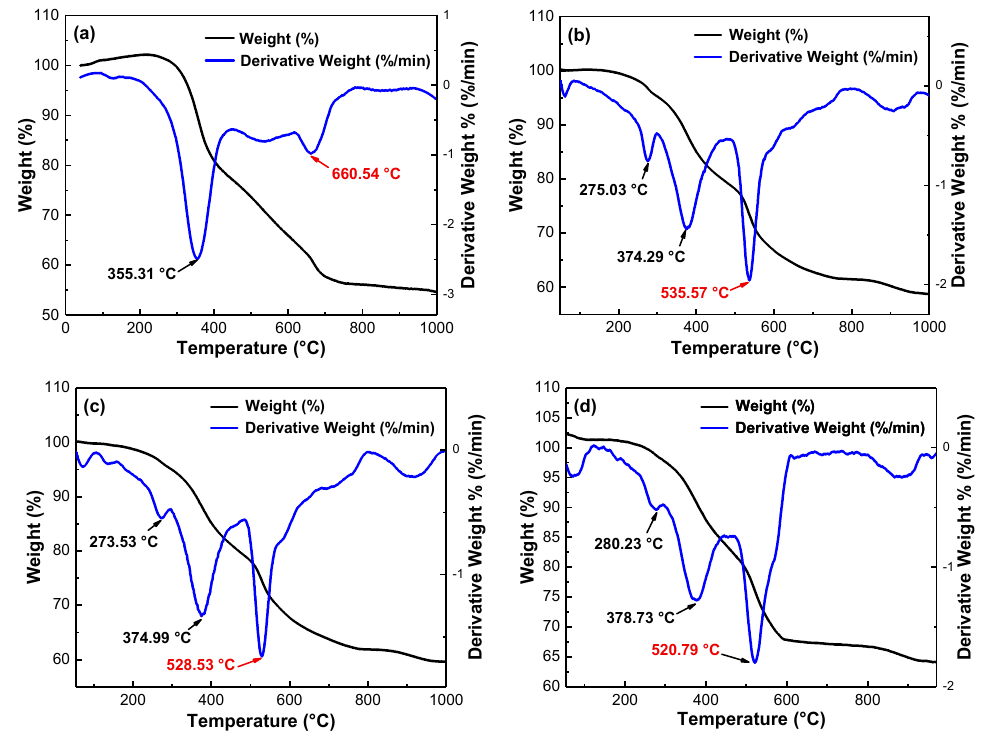
Figure 21. TGA-DTA curves of epoxy coatings exposed for different durations: ( a ) 0 years; ( b ) 7 years; ( c ) 12 years; ( d ) 20 years.